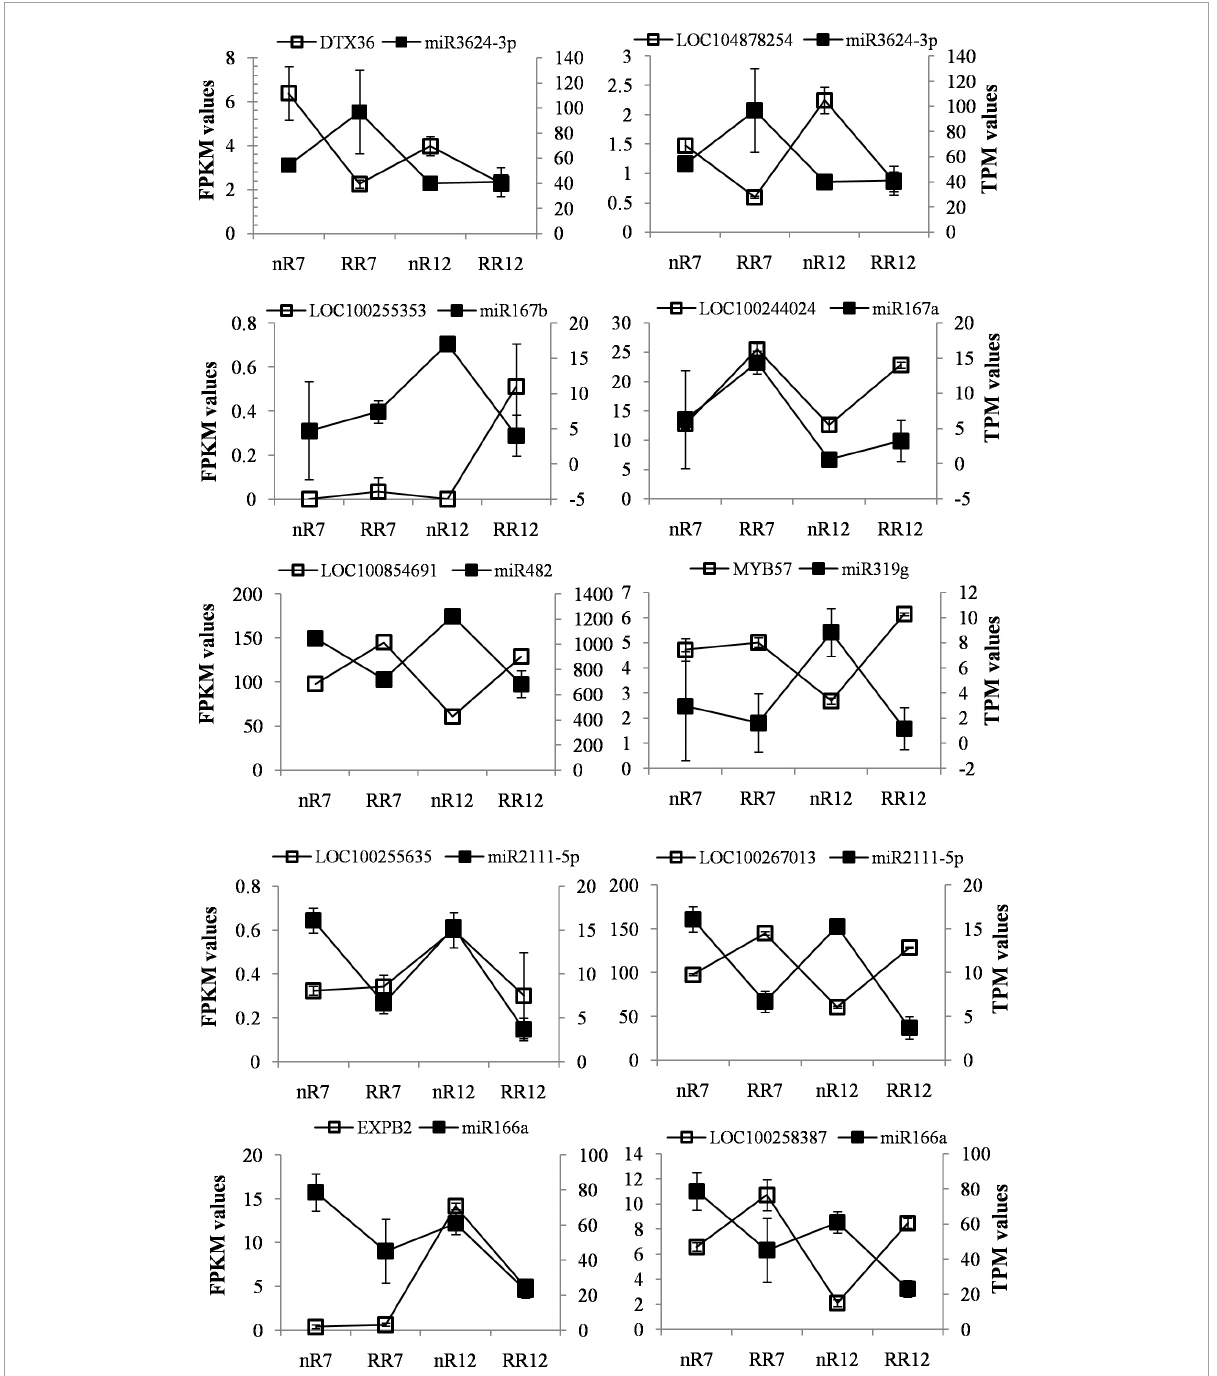
FIGURE7 FPKM and TPM values of differential expression known miRNAs and their target genes under different cultivation methods comparing groups of the nR7 vs. RR7 and nR12 vs. RR12 in four sequencing samples. nR7, RR7, nR12, and RR12 represent the 70 days DAP and 125 DAP sampling points under nR and RR